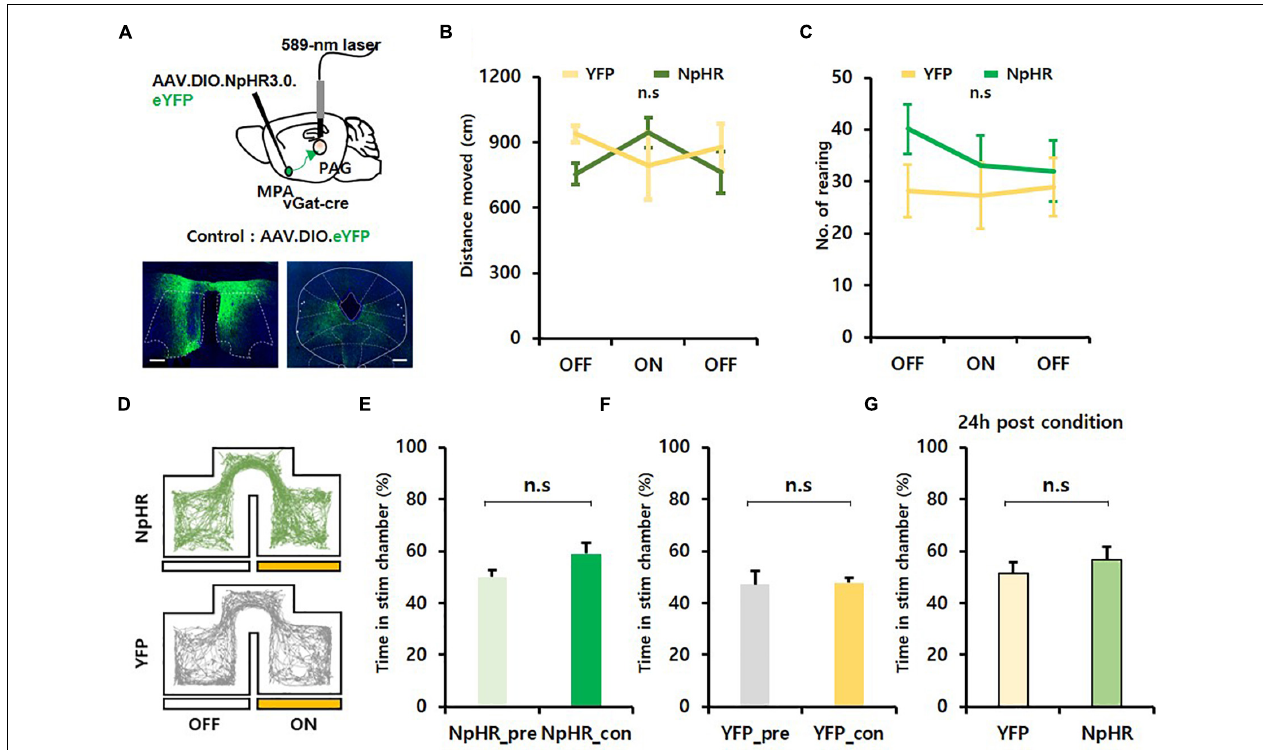
FIGURE 4 | Photoinhibition of GABAergic neurons in the MPA projecting to the vPAG does not alter exploration and does not encode value. (A) Top, MPA–vPAG circuit photoinhibition induced by a 589-nm laser. AAV.DIO.eNpHR3.0.eYFP was bilaterally injected into the MPA, and dual-fiber optic cannulas were implanted over the vPAG. Bottom, virally mediated expression of NpHR in the MPA of vgat -ires- Cre mice and axon termini in the vPAG. Scale bar, 250 µ m. (B) NpHR-expressing mice ( n = 7; n = 5 males; n = 2 females) have no significant increase in distance moved compared to eYFP control mice ( n = 4; n = 1 male; n = 3 females); OFF_pre, p = 0.169; ON, p = 0.245; OFF_post, p = 0.380. Error bars represent SD. (C) No difference in the number of rearing between NpHR-expressing mice ( n = 7; n = 5 males; n = 2 females) and eYFP-expressing mice ( n = 4; n = 1 male; n = 3 females); p = 0.431. Error bars represent SD. (D ) Representative movement trace of NpHR-expressing (green) mice and eYFP control mice (gray) during RTPP. (E) NpHR-expressing ( n = 7; n = 5 males; n = 2 females) mice show no significant difference in time spent in the stim chamber during RTPP; p = 0.098. Error bars represent SD. (F) eYFP control ( n = 4; n = 1 male; n = 3 females) have no difference in time spent in the stim chamber during RTPP; p = 0.923. Error bars represent SD. (G) Twenty-four hours after the conditioning session. eYFP control ( n = 4; n = 1 male; n = 3 females) and NpHR-expressing ( n = 7; n = 5 males; n = 2 females) mice do not have preference toward the stim chamber; p = 0.488. Error bars represent